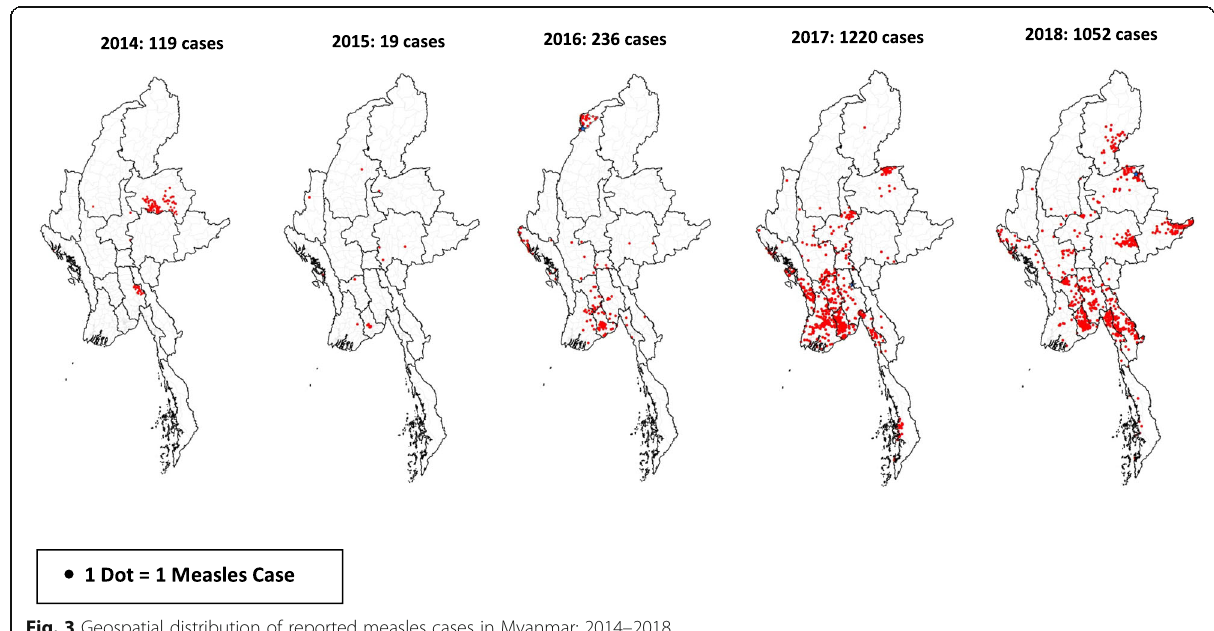
Fig. 3 Geospatial distribution of reported measles cases in Myanmar: 2014 –